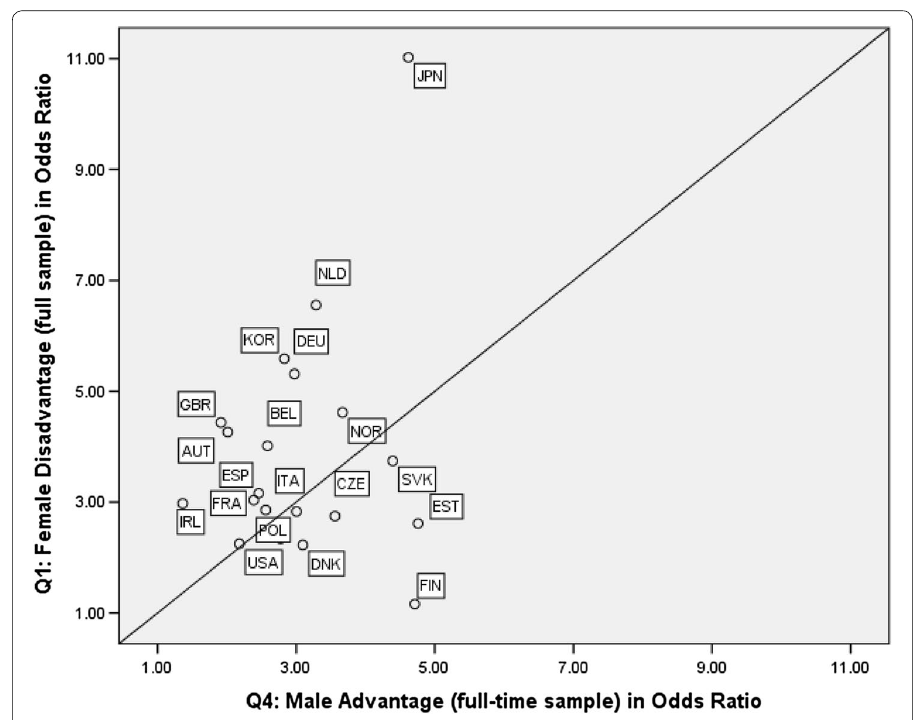
Fig. 5 Q1, Model 3: Female Disadvantage vs. Q4, Model 3: Male